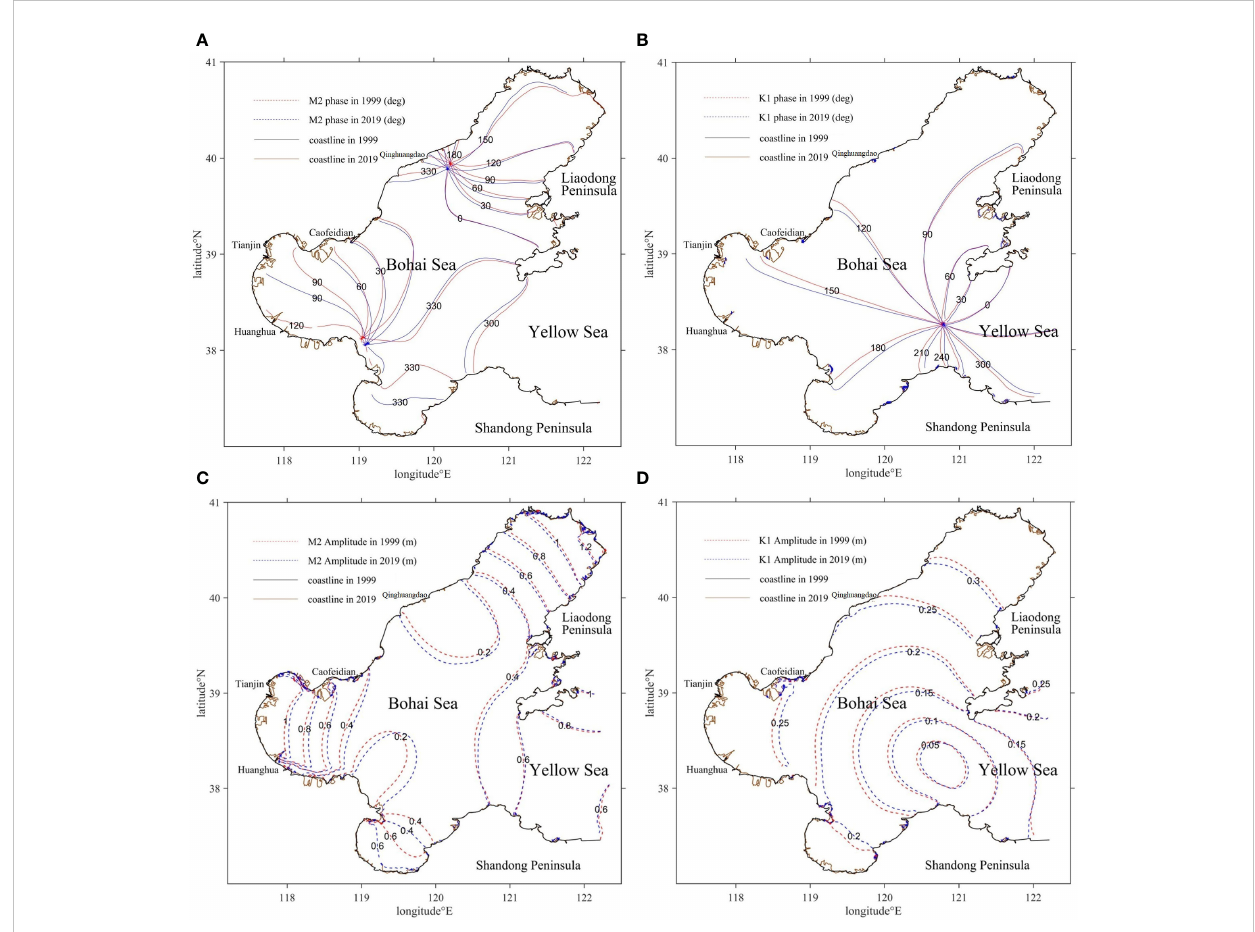
FIGURE 6 M2 and K1 tidal amplitudes and phases. (A, B) M2 and K1 tidal phases in 1999 and 2019. (C, D) M2 and K1 tidal amplitudes in 1999 and